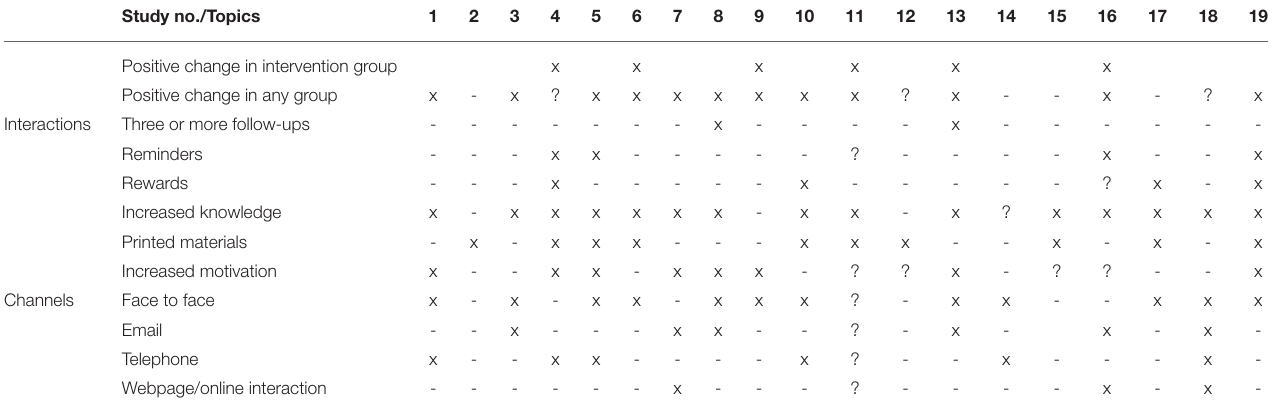
TABLE 2 | BMJ 2016;352:i1102 included clinical trials in meta-analysis, their interactions, and their communication